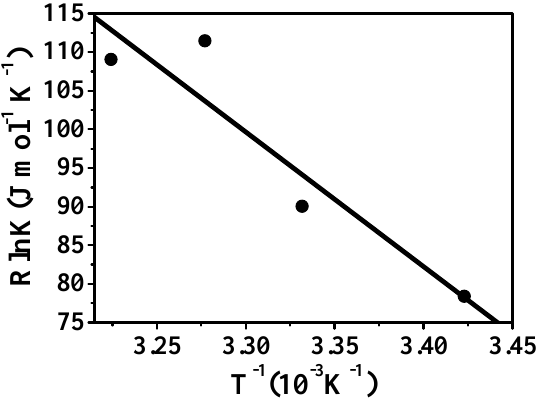
Figure 2. Van’t Hoff plots for the associations of 3 and 1 from UV-Vis